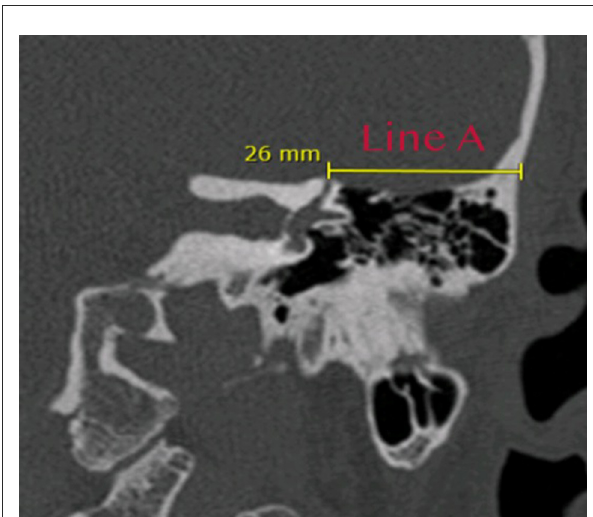
FIGURE1 HRCT coronal view illustrating how the first measurement (line A) is taken between the center of the dehiscence medially and the most lateral part of the squamous part of the temporal bone. This line identifies the distance that will be crossed over the superior surface of the temporal bone from the craniotomy laterally to the dehiscence of the superior canal medially, 26mm in this example.